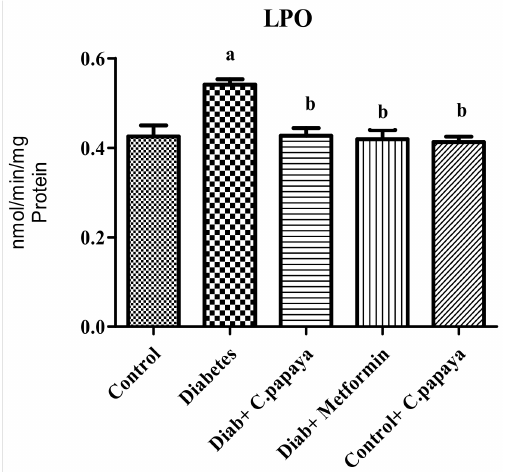
Figure 6. This figure represents the outcome of the ethanolic extract of C. papaya on the oxidative stress marker (LPO) in the skeletal muscles (gastrocnemius muscle) of control and diabetic rats. Each bar indicates the mean ± SEM of eight rats, with p < 0.05 indicating significant differences between the groups as: a—control and